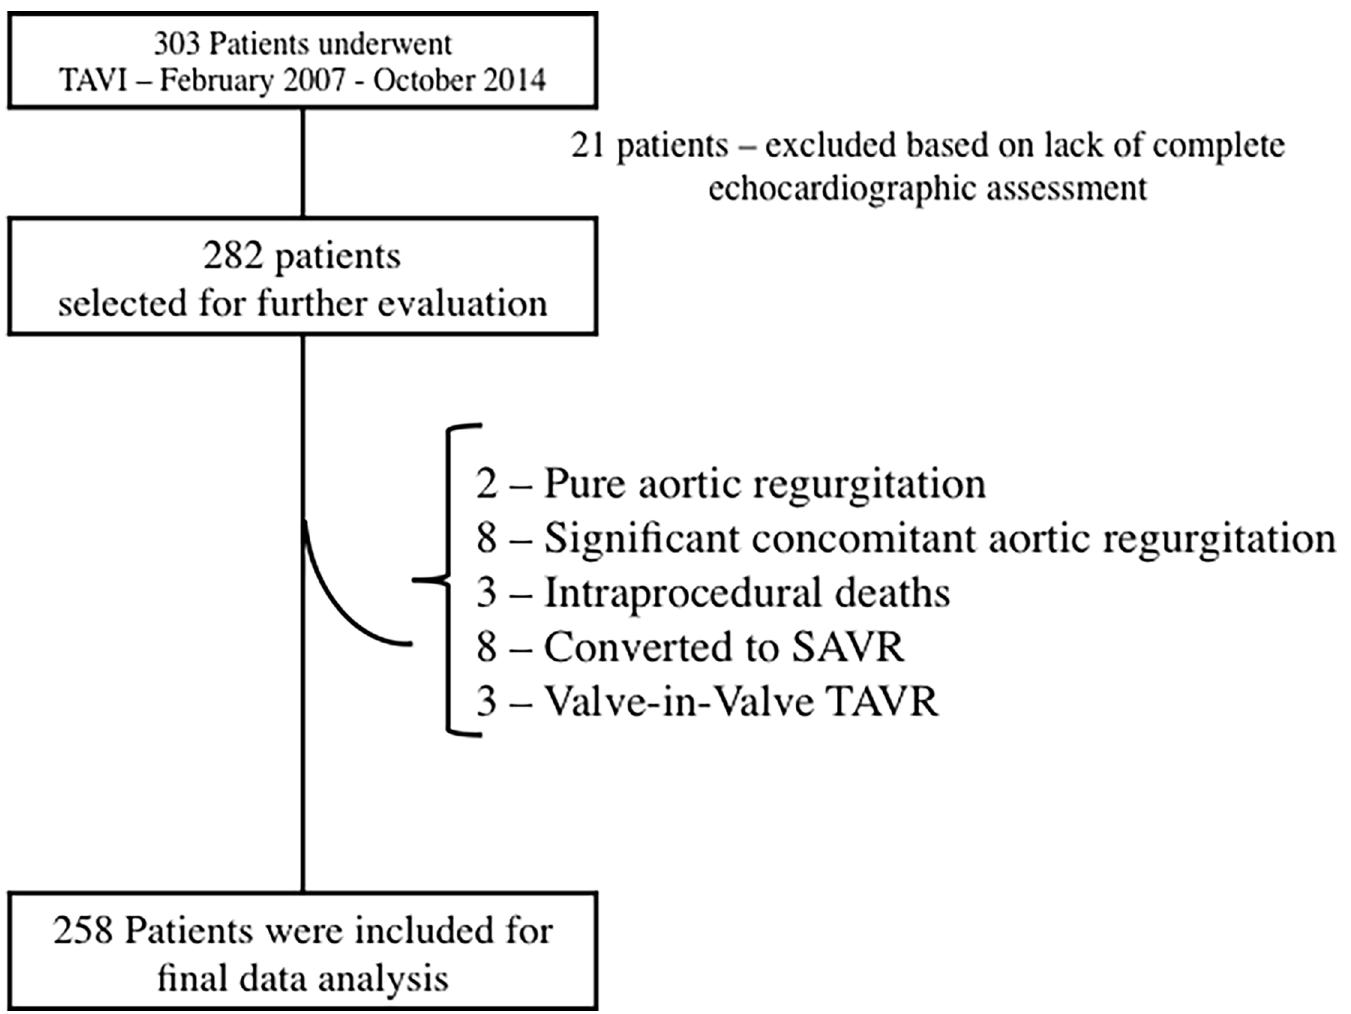
Fig 1. Study protocol of inclusion and exclusion criteria. SAVR = surgical aortic valve replacement, TAVR = transcatheter aortic valve replacement.